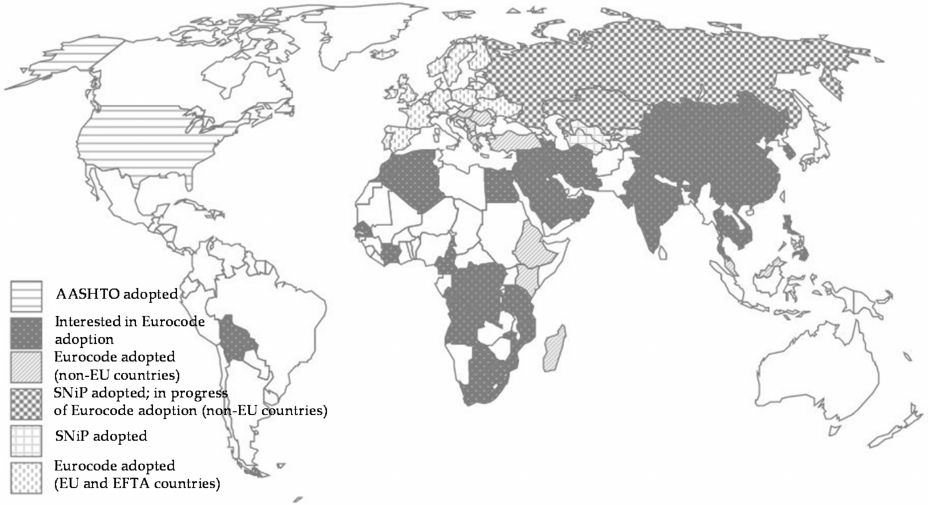
Figure 1. Distribution of design codes around the world (modified from